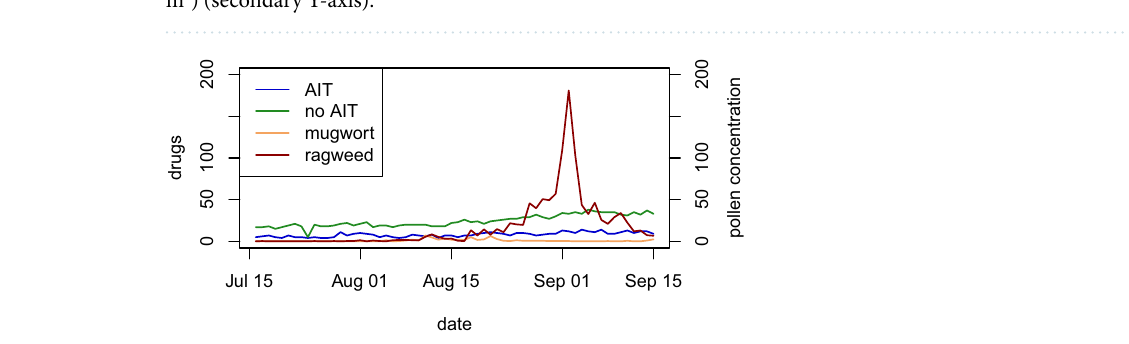
Figure 3. Time series of observed total number of symptoms for the three categories in the two groups of patients: AIT treated (left) and no AIT (right), and mugwort mean daily pollen concentrations (pollen grains/ m 3 ) (secondary Y-axis).